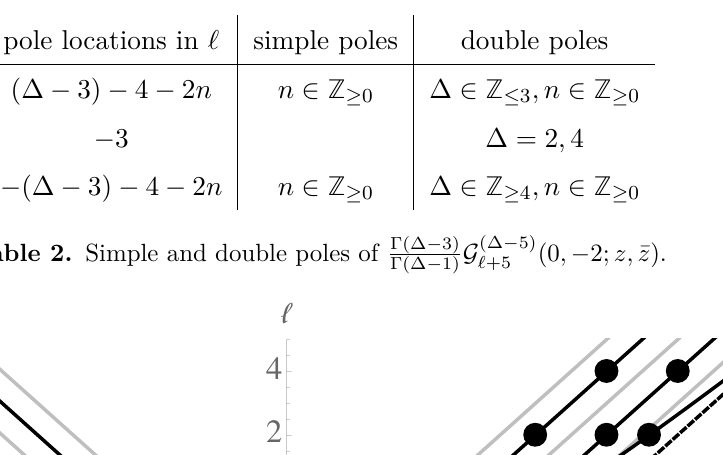
Figure 6. Regge trajectories (black) and kinematical poles (gray) of c (∆ , ‘ ) /K 0 , − 2 dots indicate physical operators with the red one corresponding to the stress tensor multiplet. The dashed line indicates the asymptotic double twist behavior of the leading long multiplets. The gray crosses indicate double